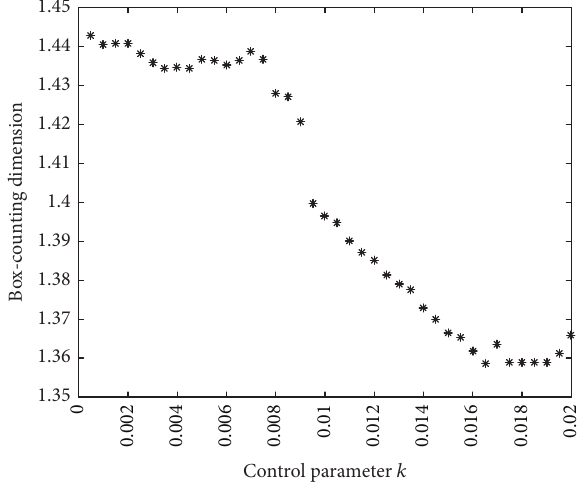
Figure 11: The change of box-counting dimensions of the Julia sets of the controlled system when 𝑘 is from 0.0005 to